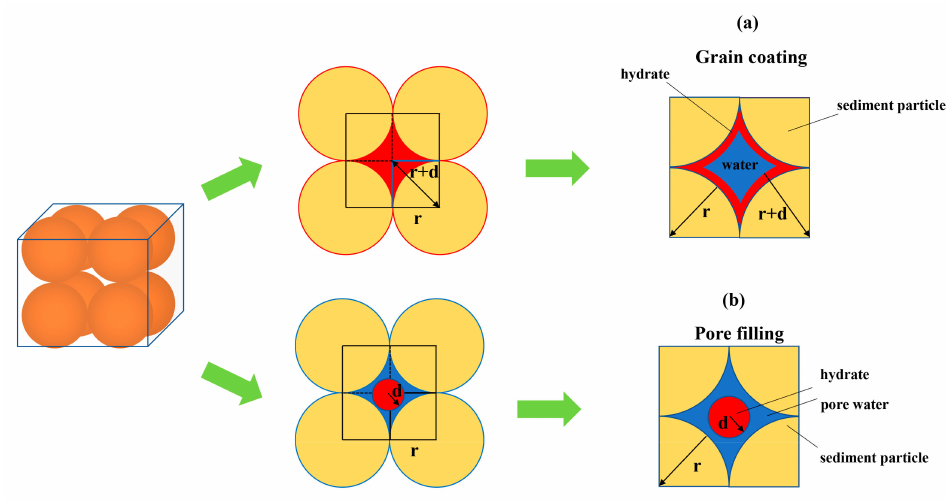
Figure 7. Two filling models of Cubic